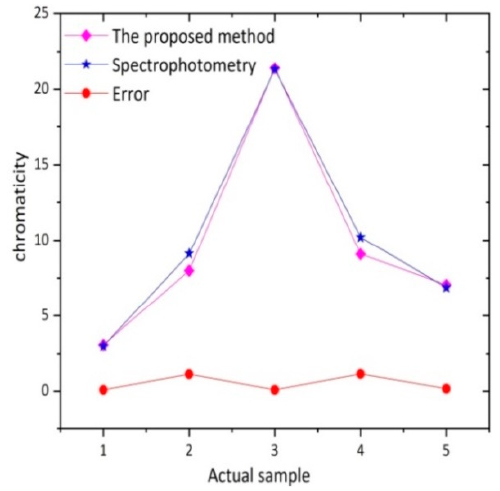
Figure 12. Comparison of measuring results for actual water samples. Table 4. Comparison of measurement results by two methods.